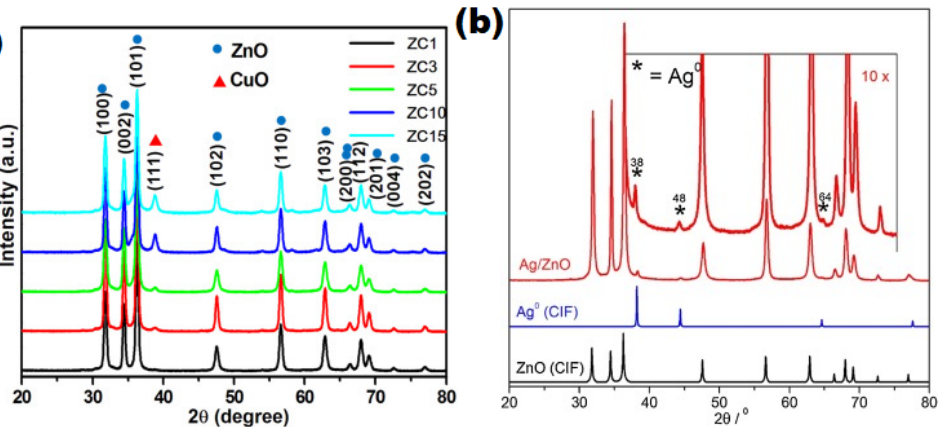
Figure 4. Representative PXRD of zinc oxide composite materials: ( a ) ZnO/CuO [86], ( b ) ZnO/ Ag (* = peaks associated with Ag 0 )